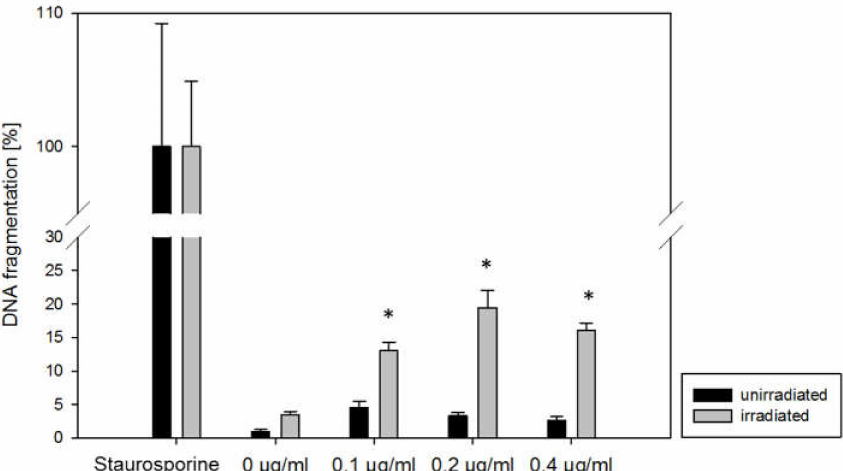
Figure 2. Histone-associated DNA fragments released from A498 RCC incubated for 1 h with curcumin (0–0.4 µ g/mL) and irradiated with 5500 lx visible light for 5 min (grey) or kept light protected (black). Twenty-four hours later, cell supernatants were prepared. The positive control was incubated with 1 µ M staurosporine (set to 100%). Each column represents the mean ± S.D. of a representative experiment done in triplicate. * indicates significant difference to cells with no curcumin (0 µ